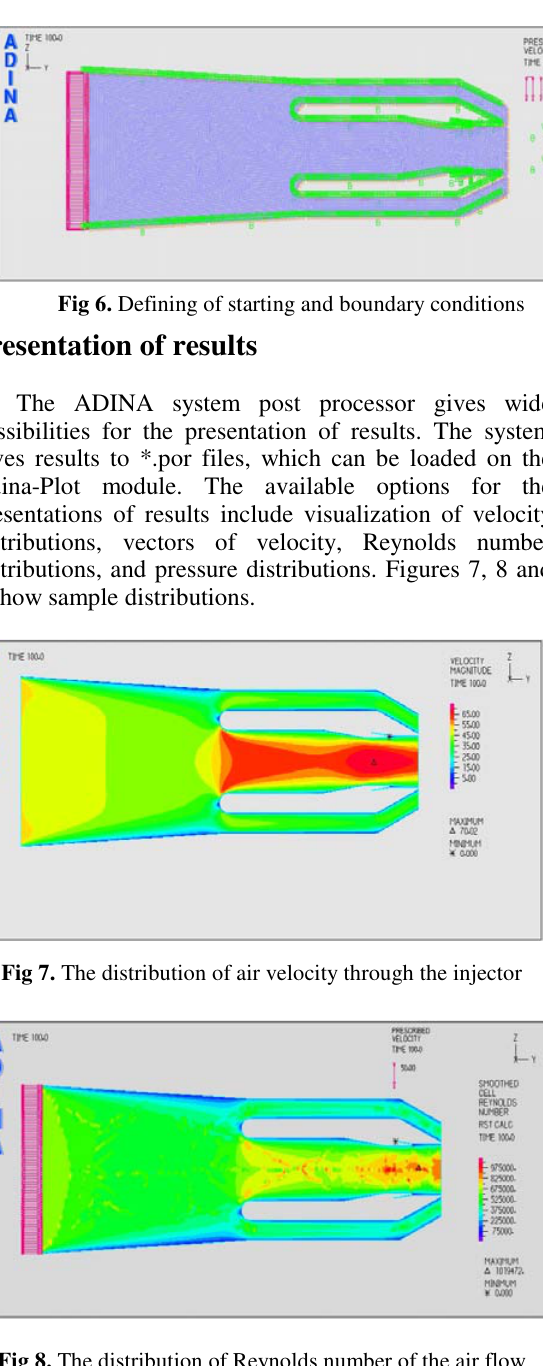
Fig 8. The distribution of Reynolds number of the air flow through the injector